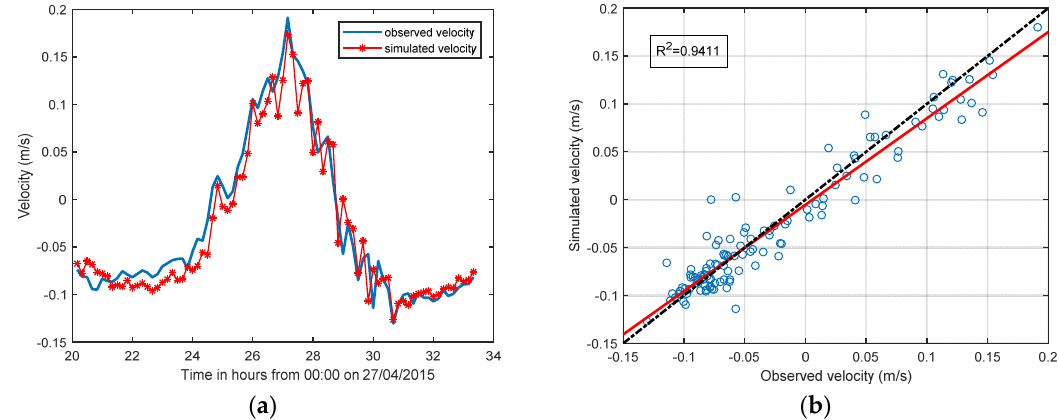
Figure 9. Eulerian calibration: ( a ) Observed vs. Simulated velocity at n = 0.025, ( b ) correlation between observed and simulated velocity at n = 0.025.